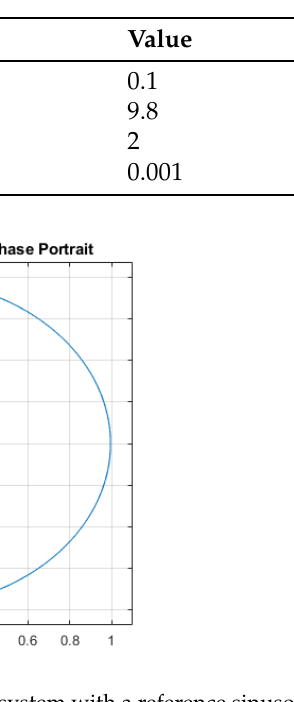
Table 2. Lyapunov controller parameters.